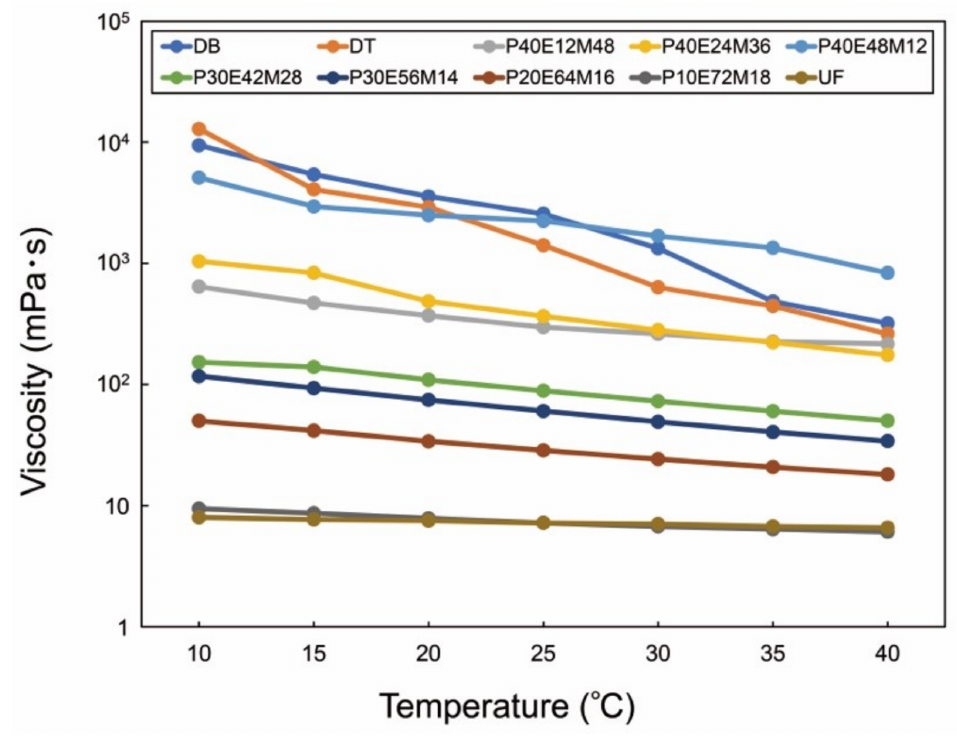
Figure 2. Viscosities of printable PMMA-based resins and commercial 3D-print resins (DB and DT). The printable PMMA-based resins did not contain photo-initiator to avoid unintentional curing by ambient light during the